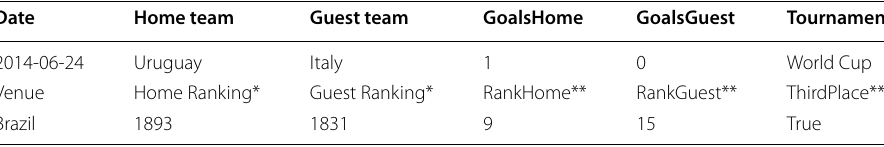
* ’Ranking’ refers to the Elorating ranking index on the match date